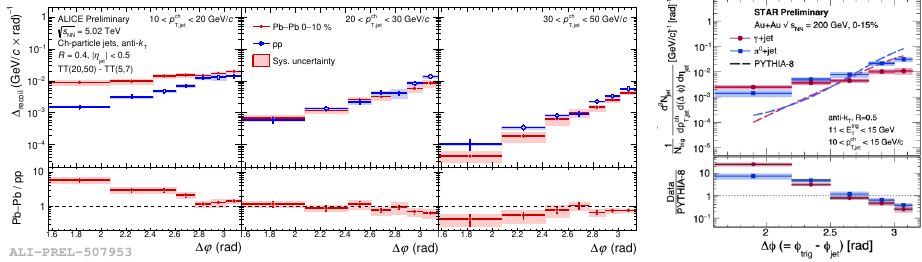
Figure 4. Left: The background-subtracted hadron + jet trigger normalised recoil jet distributions in central 0-10% Pb–Pb collisions and pp collisions, as a function of the azimuthal angle between the trigger and the jet ∆ φ , for di ff erent p jet intervals, measured by ALICE. Right: The γ -jet and π 0 -jet T trigger-normalised recoil jet distribution as a function of ∆ φ in central 0-15% Au–Au collisions, mea- sured by